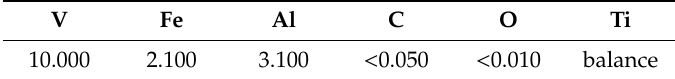
Table 1. The nominal chemical composition of Ti-10V-2Fe-3Al (wt.%).